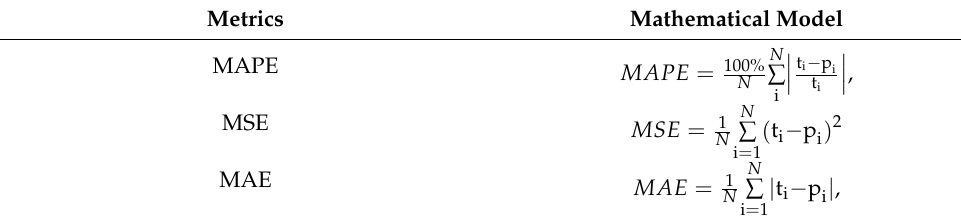
Table 6. Evaluation functions for three prediction